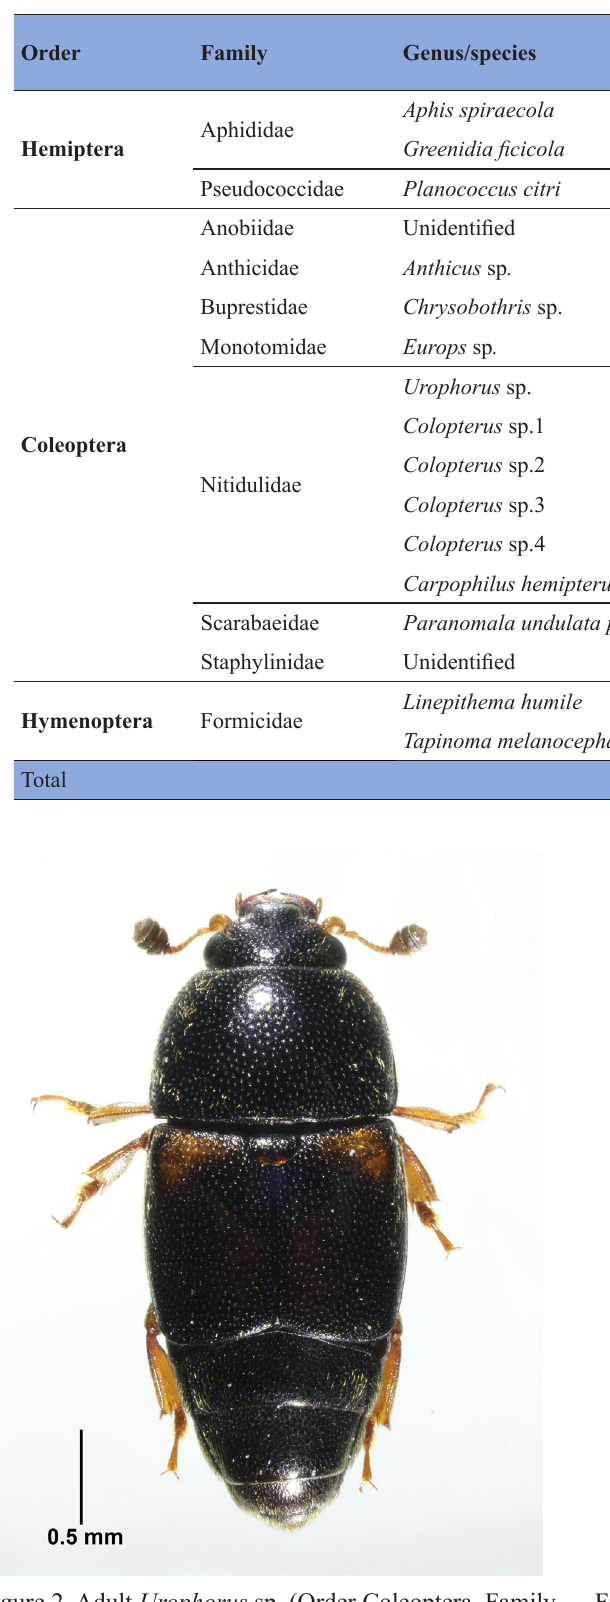
Figure 3. Adult Carpophilus hemipterus . (Order Coleoptera, Family